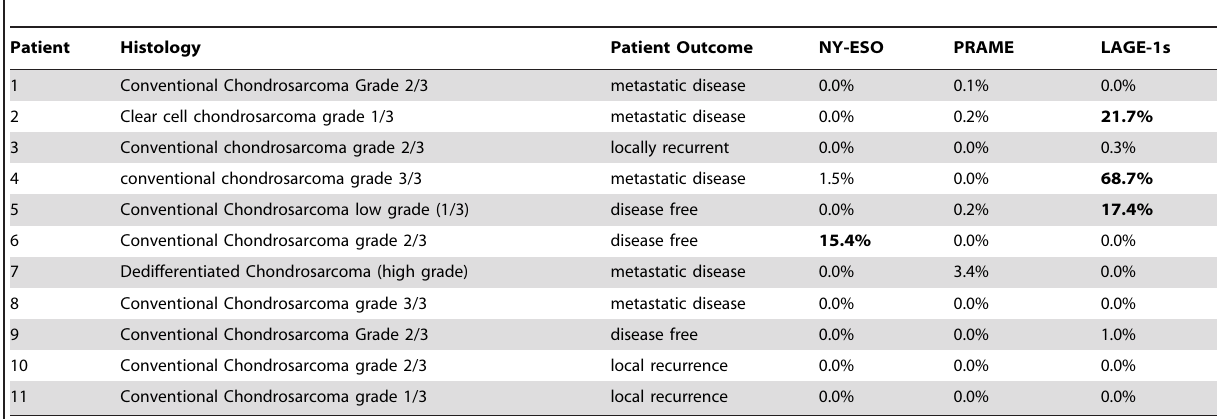
Table 2. qRT-PCR results on flash frozen chondrosarcoma tumors from the UW Sarcoma Tissue Bank relative to positive Control Cell Lines Mel375 (for NY-ESO-1 and PRAME) and JJ (For LAGE-1s).